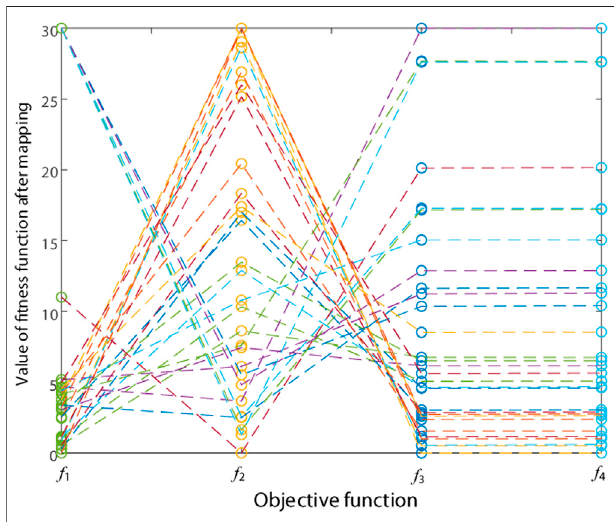
FIGURE 10 | Pareto front